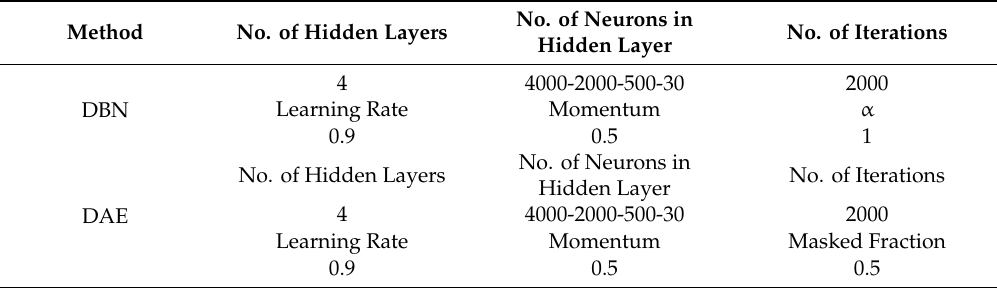
Table 7. Parameters of DBN and DAE.